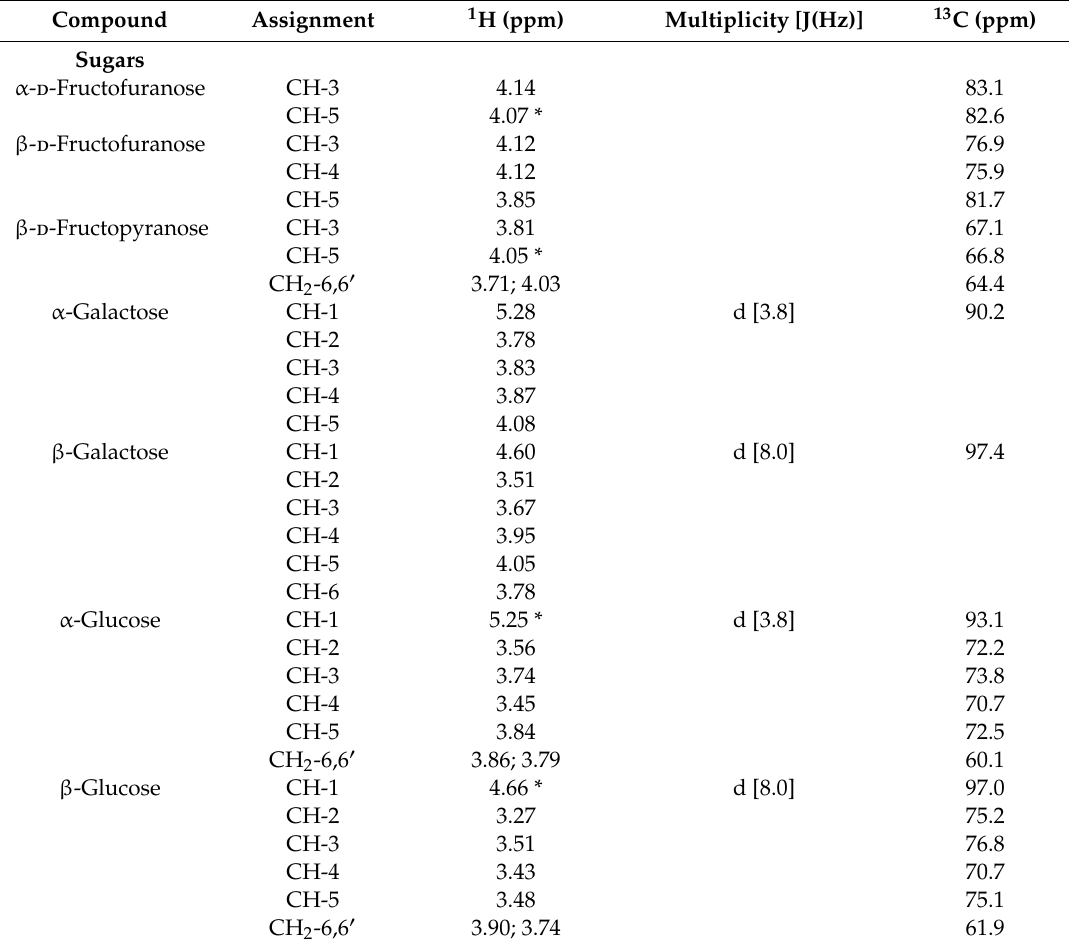
Table 1. Metabolites identified in the 600.13 MHz 1 H-NMR spectra of the Bligh-Dyer